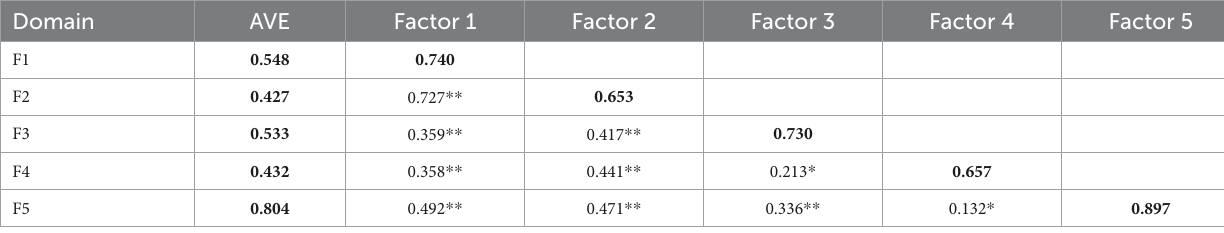
TABLE 4 Estimated correlations between domains and average variance extracted (AVE) of each domain ( N = 360).